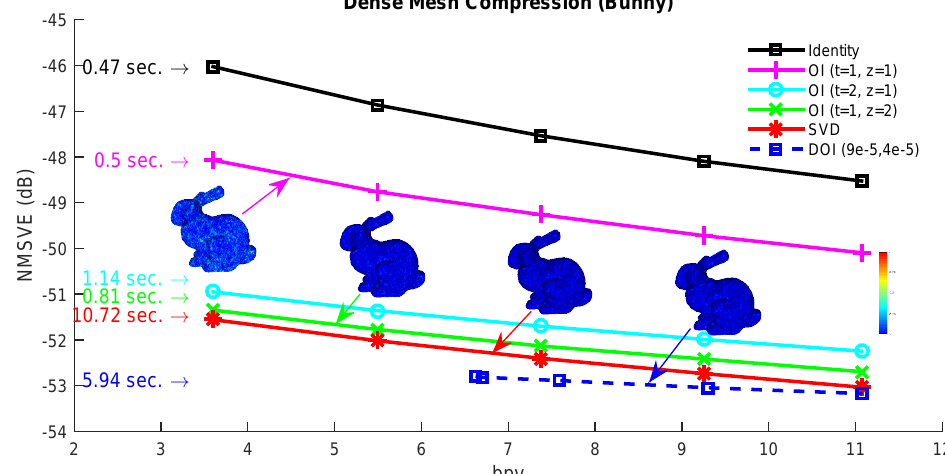
Figure 12. Normalized mean square visual error (NMSVE) of the reconstructed models per different bpv for different compared